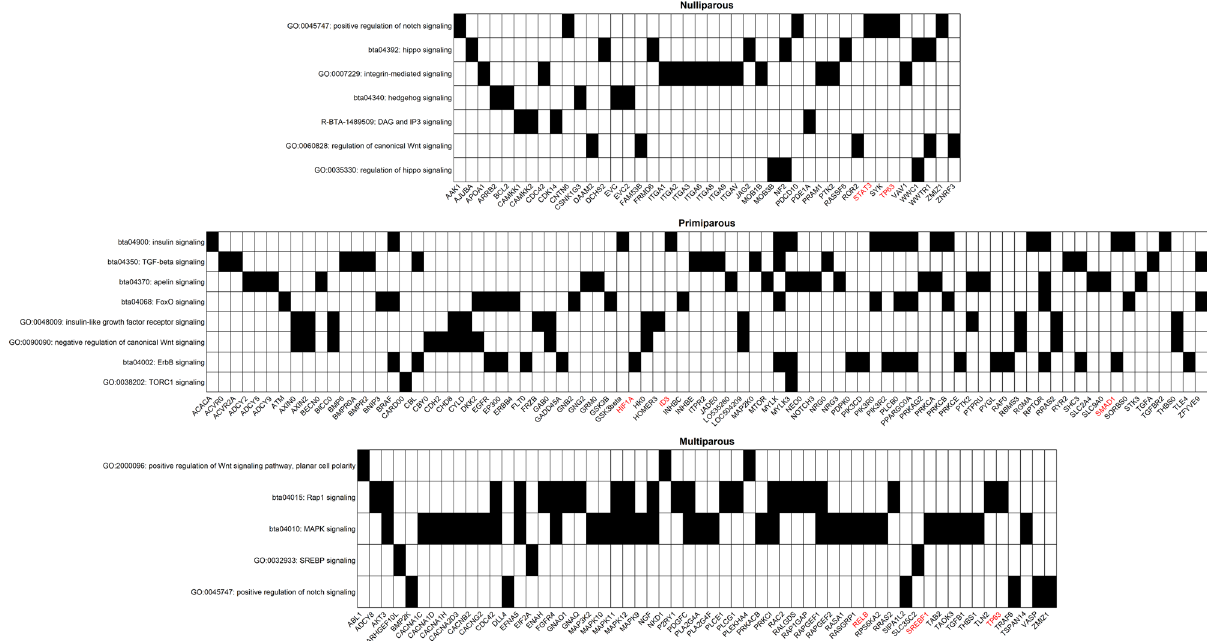
Figure 3. Heatmap plot of gene signaling pathways associated with pregnancy loss across the three parities. The y-axis displays the names of gene signaling pathways, and x-axis displays the names of genes involved in the pathways. Genes highlighted in red are recognized as bovine transcription